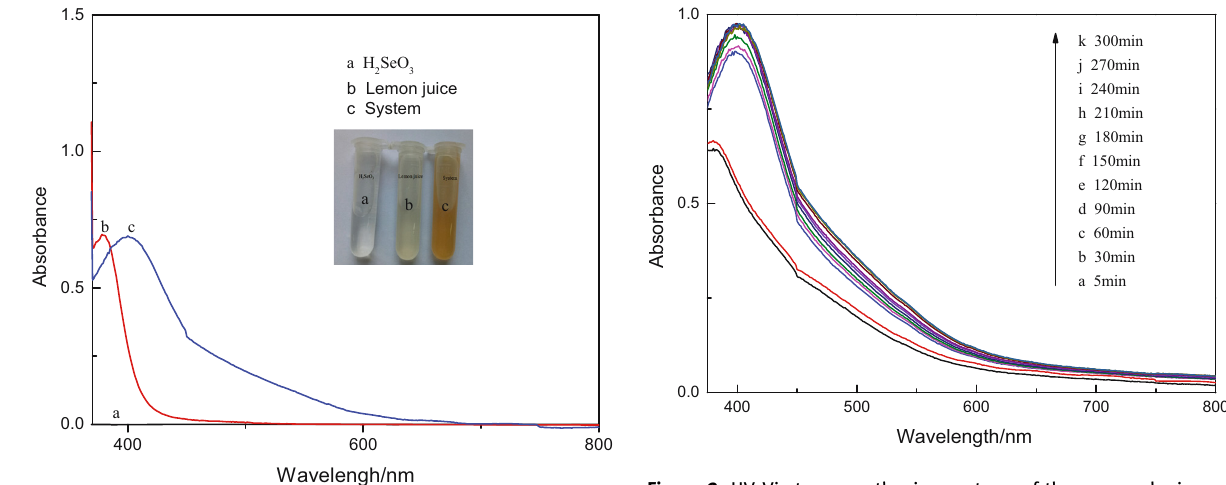
Figure 2: UV - Vis trace synthesis spectrum of the nano - selenium